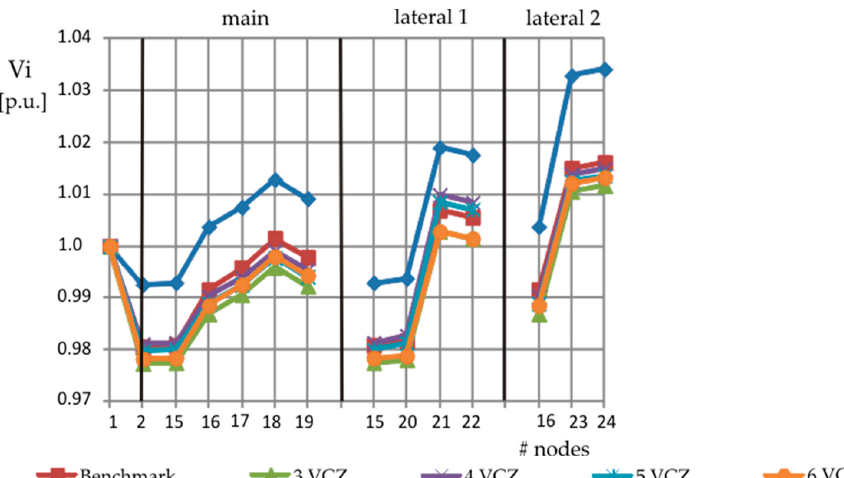
Figure 7. Voltage profiles for Case R —DG: Q algorithm—feeder 2. Figure 7 : Voltage profiles for Case R — DG: Q algorithm—feeder 2. Figure 7 : Voltage profiles for Case R — DG: Q algorithm—feeder 2.